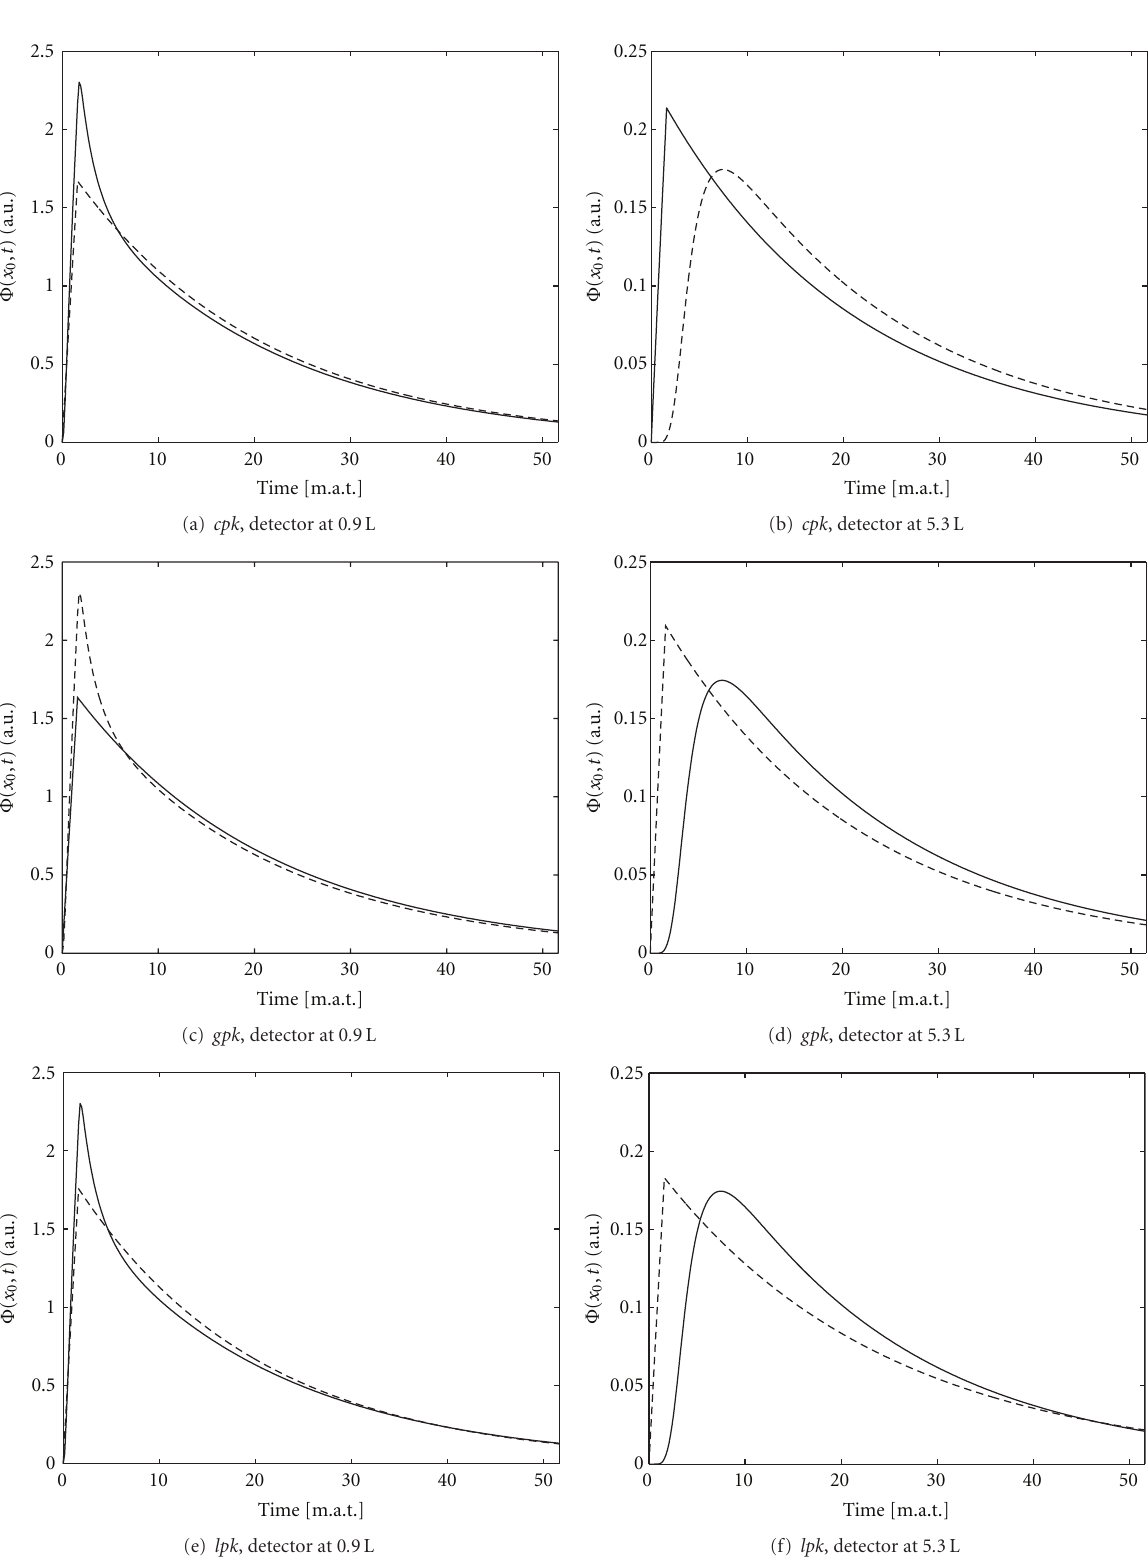
Figure 5: Evolution of the local flux following a source pulse in a subcritical system ( k e ff = 0 . 95) for two detectors, at x 0 = 0 . 9L (a, c, and e) and at x 0 = 5 . 3L (b, d, and f), adopting di ff erent formulations of the point kinetic model. Solid line: reference; dashed line: point